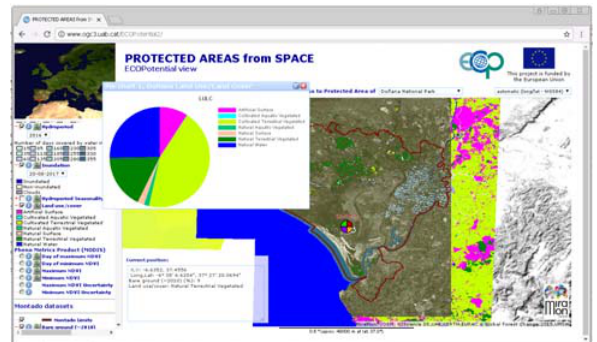
Figure 8. Screenshot showing a pie chart representation for a categorical dataset (a Land Use Land Cover Map) for the Doñana National Park.